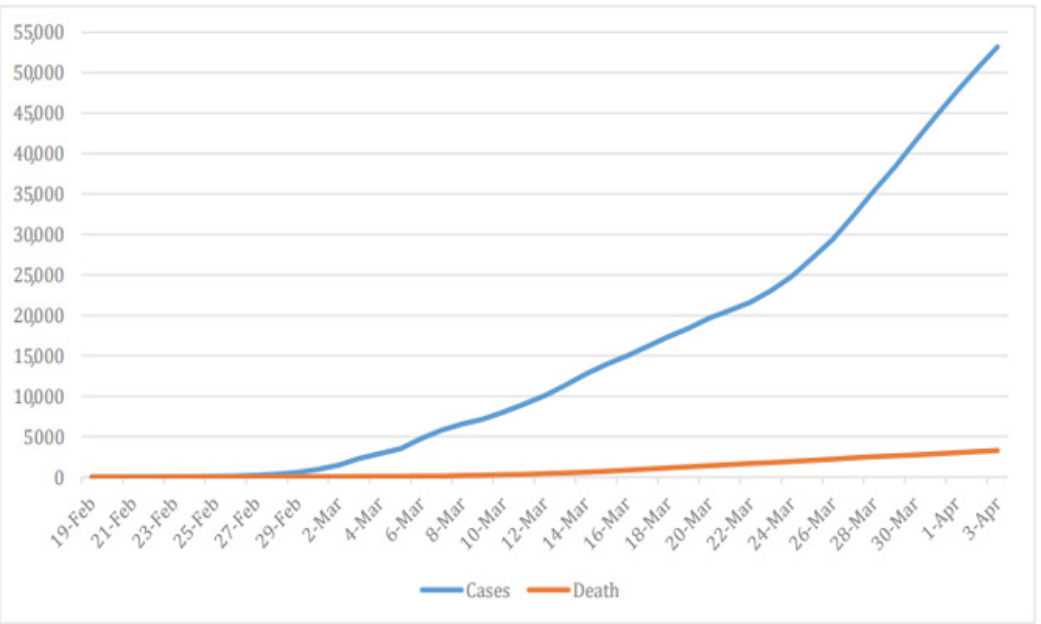
Figure 1. Daily number of deaths and daily number of cases since the beginning of the outbreak in Iran. Reproduced from [4], Copyright 2020, Raoofi, A.; Takian, A.; Sari, A.A.; Olyaeemanesh, A.; Haghighi, H.; Aarabi, M.